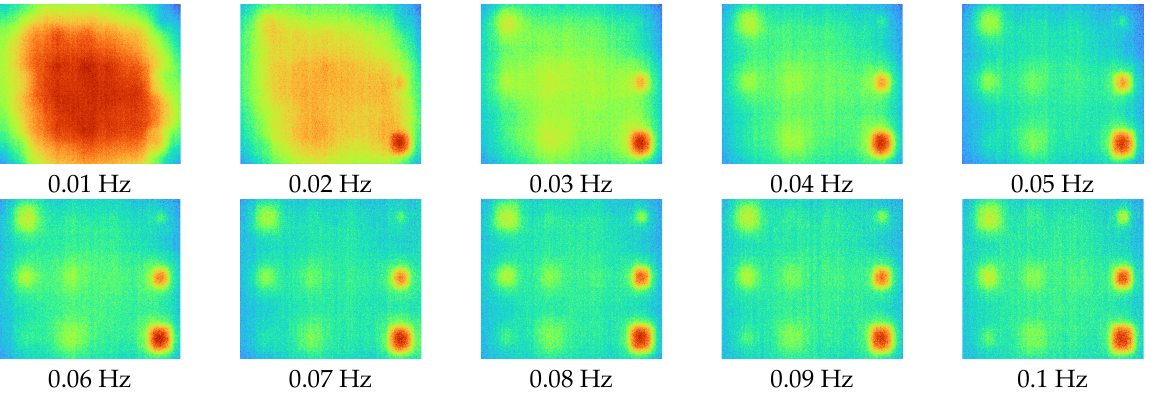
Figure 8. Amplitude images for excitation frequencies range from 0.01 to 0.1 Hz.